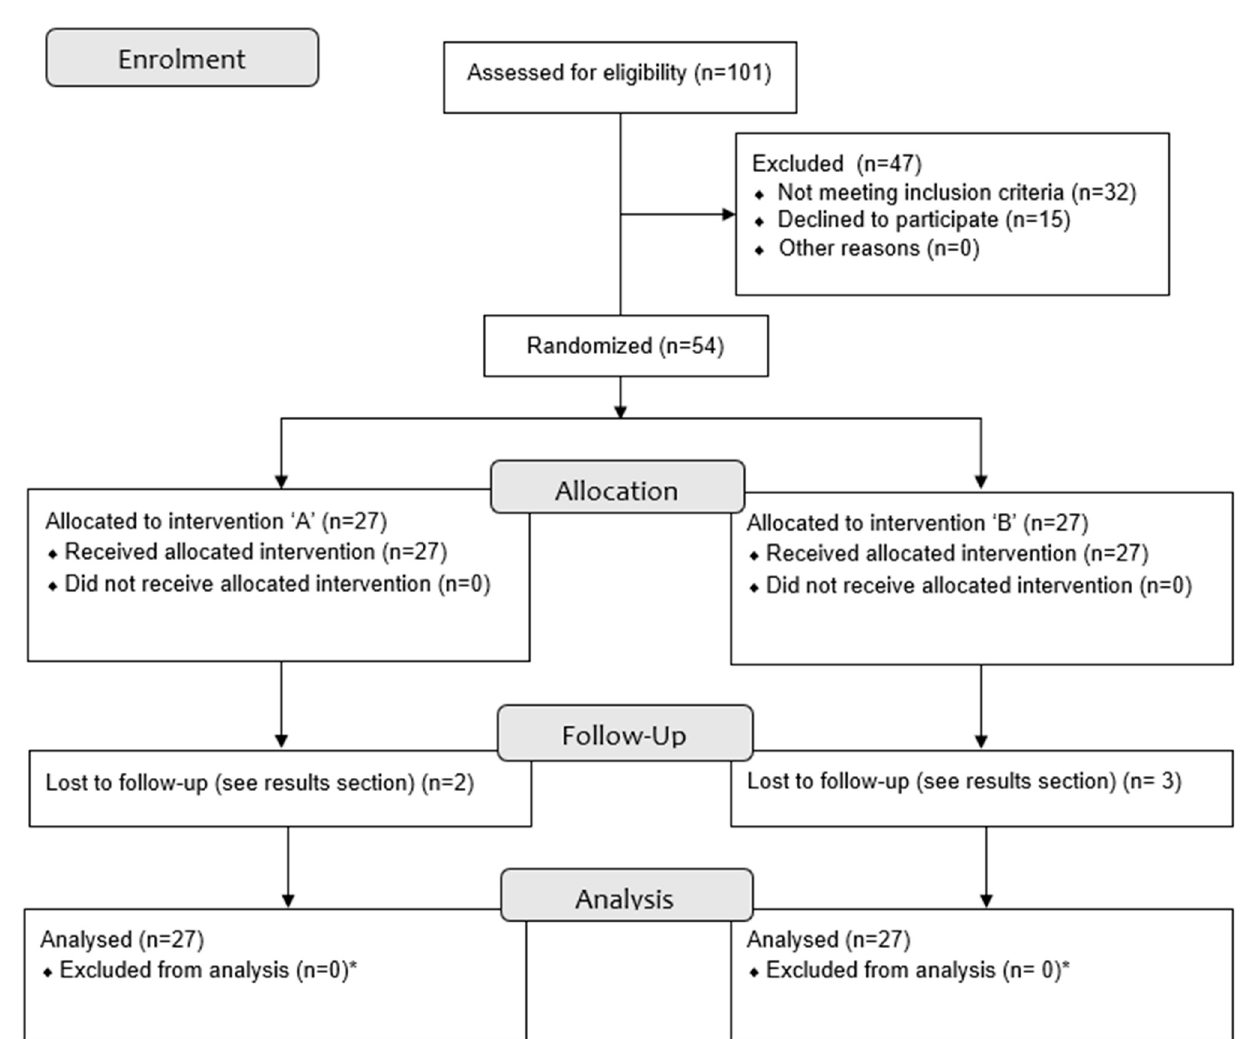
Figure 1. Flow diagram of participant enrolment. * Only the ‘lost to follow up’ missing values were excluded from analysis.